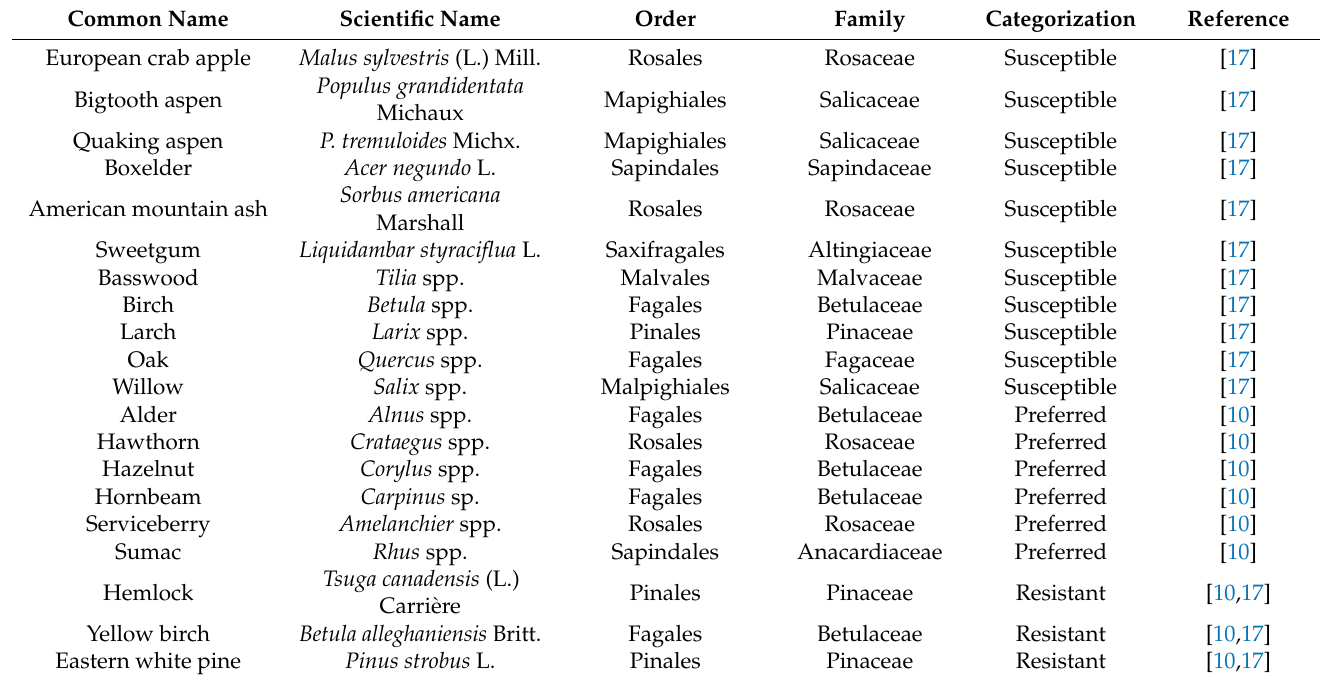
Table 1. Susceptible, preferred, and resistant tree species to Lymantria dispar